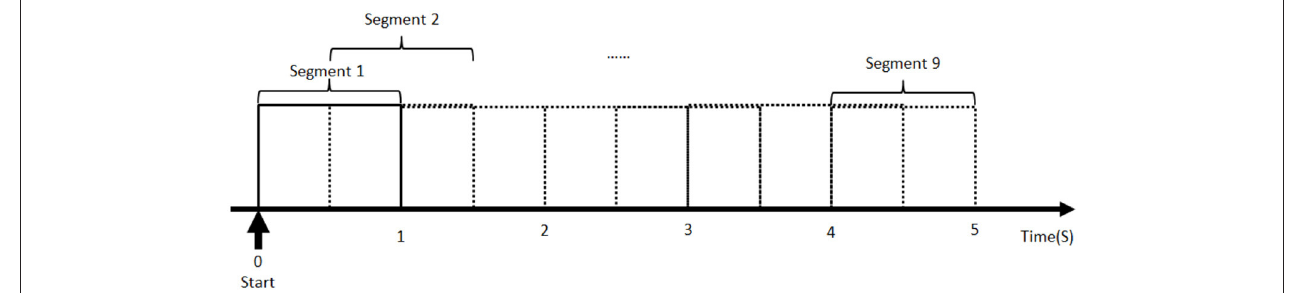
FIGURE 5 | Data segmentation of each picture stimulation trial.